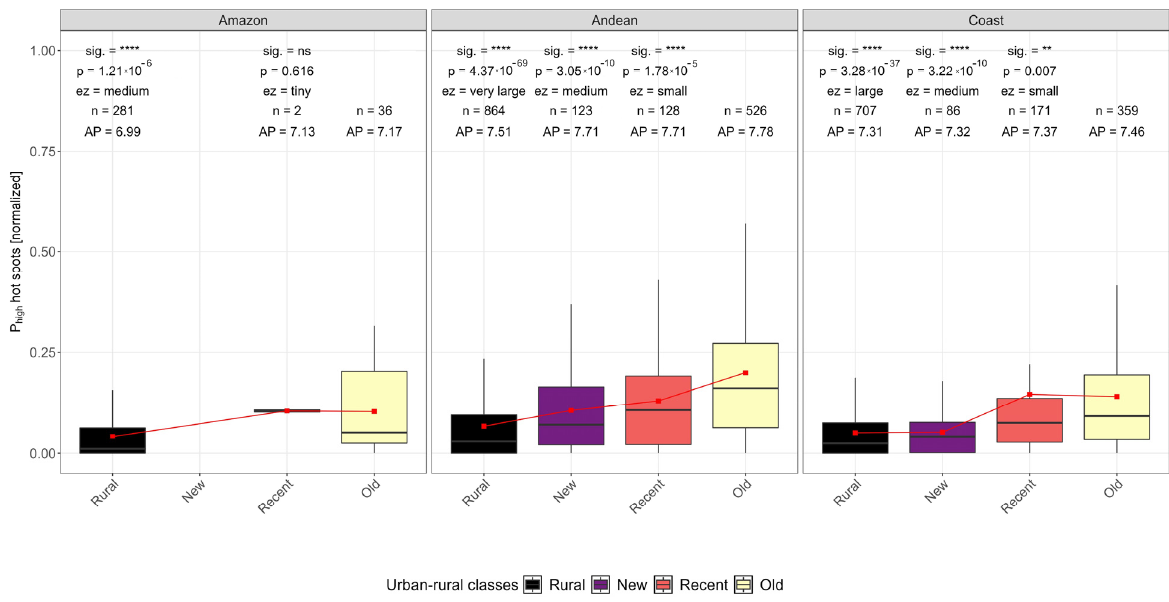
Figure 9. Boxplots of the normalized high academic performance (AP) probability ( P high ) hot spot values for each urban– rural gradient map class and region. Text in plots refer to the results of the Wilcoxon–Mann–Whitney test, showing significance ( sig .), p -values ( p ), effect sizes ( ez ), sample sizes ( n ), and mean AP scores ( AP ). Red lines connect the mean values. Outliers are hidden to facilitate visualization.